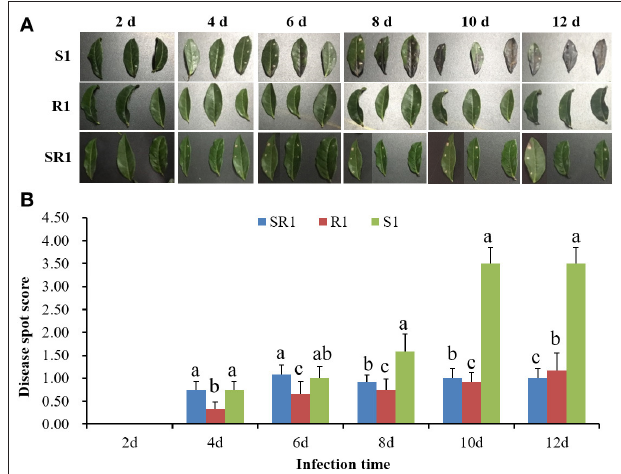
FIGURE 1 | (A) Analysis of the interaction between wild tea leaves and tea gray blight pathogen. (B) Disease resistance analysis of wild tea plant resources and tea gray blight pathogen. S1, Susceptibility 1; R1, Resistance 1; SR1, Sub-resistance 1. Different lowercase letters in the histogram indicate significant difference of disease spot score among “S1”, “SR1”, and “R1” at the same time of infection ( p < 0.05, SNK-q test).